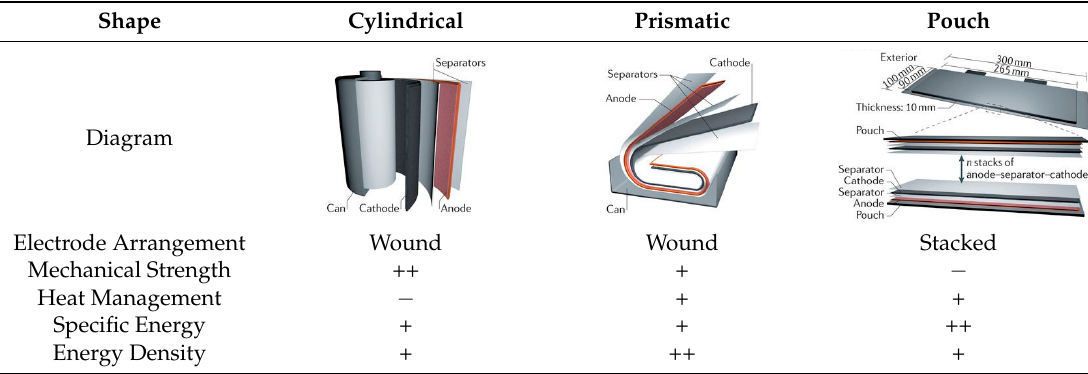
Table 1. Cell designs and Relative Strengths and Weaknesses. Figures adapted from [84] with permission. Shape Cylindrical Prismatic Pouch